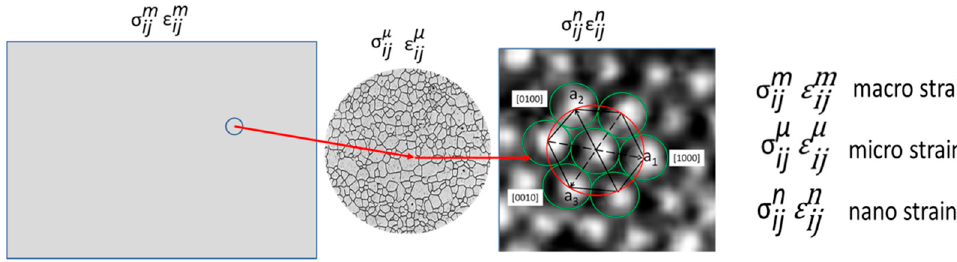
Figure 8. Illustration of three scales of experimental observation of images captured in experimental mechanics.